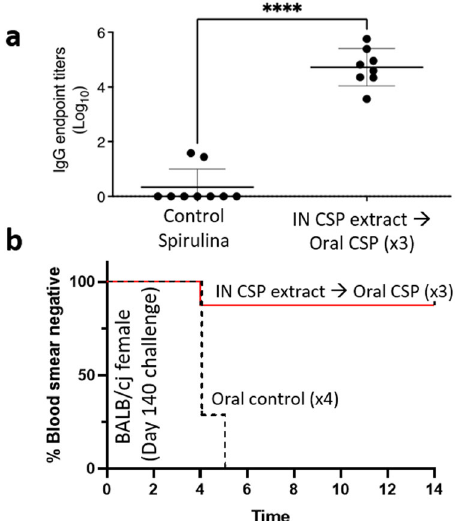
Fig. 5 Durability of protection after spirulina PfCSP vaccination. Female Balb/cJ mice were primed (orally or intranasally as shown), then orally boosted, and then challenged intravenously with wild- type PfCSP Py spz 84 days after the last vaccination (Day 140). a Pre- challenge endpoint titer ELISA results for female BALB/cJ mice. Error bars show standard deviation; **** p < 0.0001 (log-rank Mantel-Cox test). Vaccinated datapoints represent titers of individual mice on day 139; controls datapoints are titers for pooled sera on each collection day throughout the trial since there was zero response detectable on day 139 in controls. b Survival curve of protection endpoint based on blood smear positivity. The vaccination regimen is shown in text adjacent to each line. n = 8 mice/group. All vaccines shown contained Montanide. IN intranasal. Survival curve p = 0.0008 (log-rank Mantel-Cox